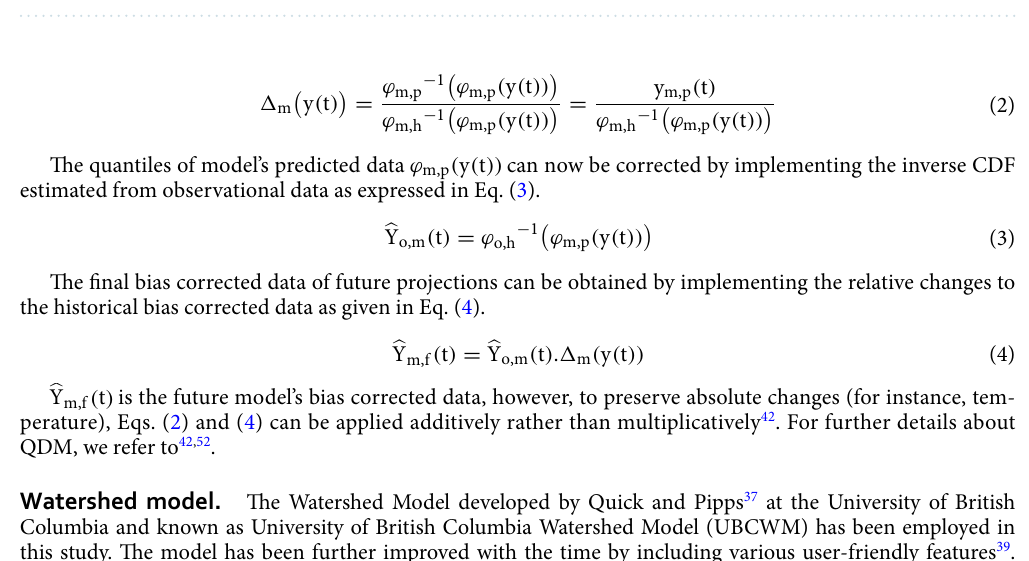
Figure 2. Schematic presentation of the methodology of the study to reach the objectives. The activities within blue line were performed for this